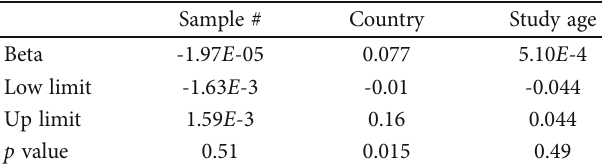
Figure 2: Pathways driven by LA/LSCC in fl uencing the expression and activity of PPARD: (a) LA-driven pathway; (b) LSCC-driven pathway. Table 2: Multiple linear regression analysis of three potential factors for PPARD expression in